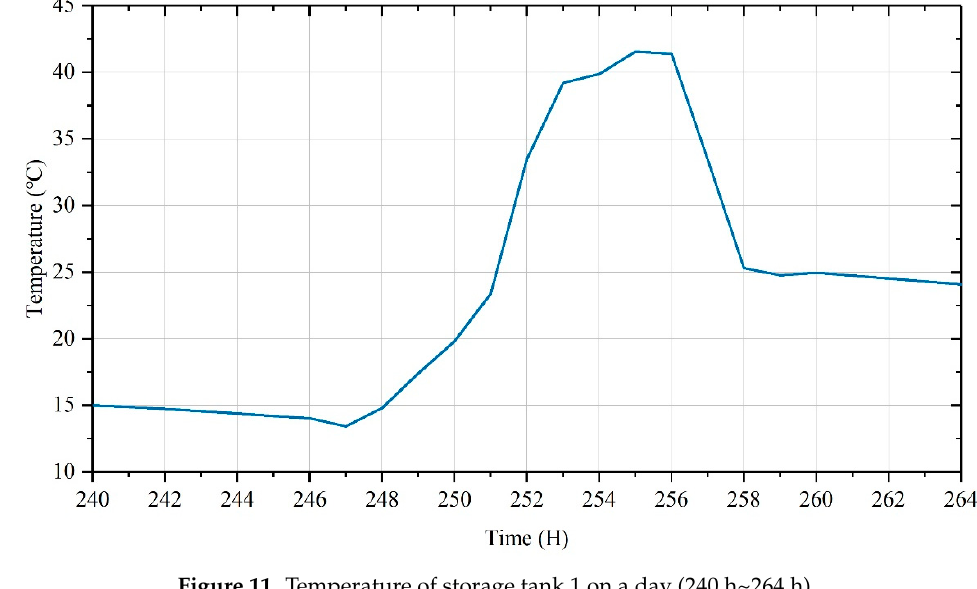
Figure 11. Temperature of storage tank 1 on a day (240 h ~264 h).